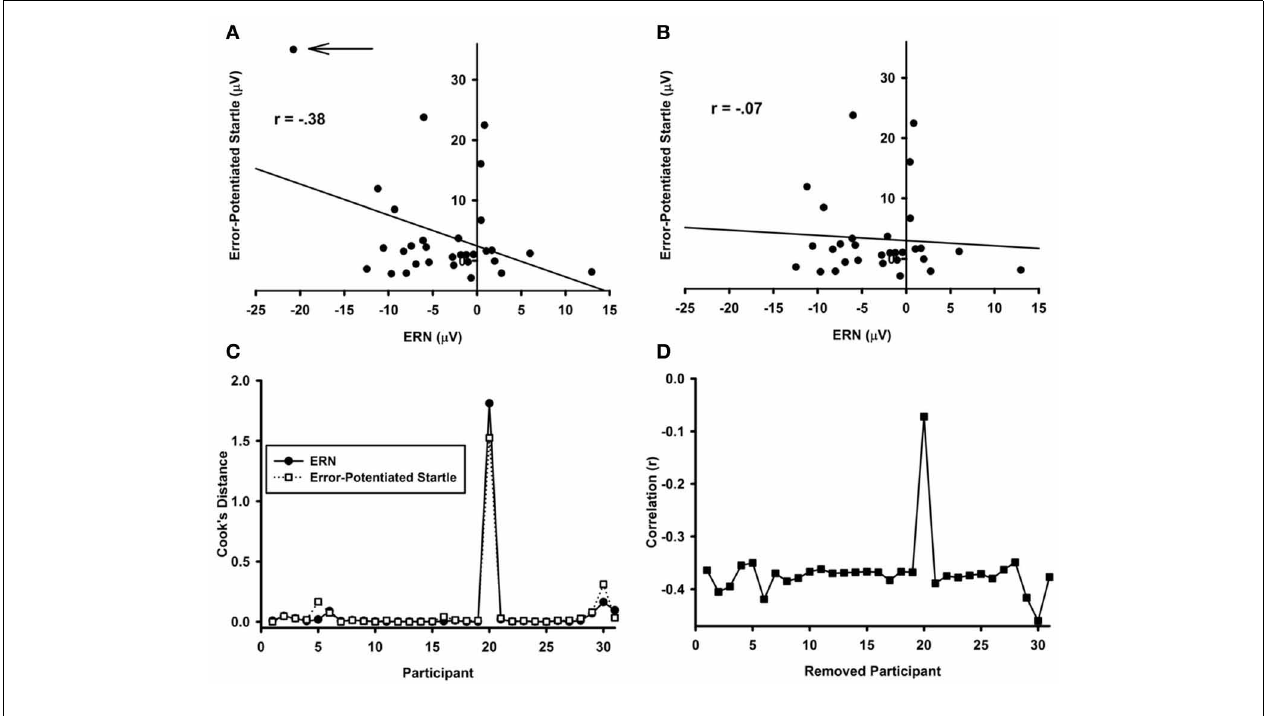
FIGURE A1 | (A) The reproduced scatterplot; the arrow indicates an outlying data-point. (B) The reproduced scatterplot after the outlying data-point has been removed. (C) Cook’s Distance for each participant.